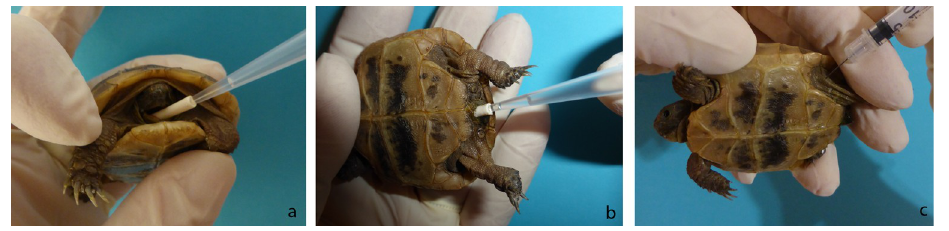
Fig 1. Inoculation of the tortoises. a: oronasally; b: intracloacally; c: Intracoelomically; here T . graeca .